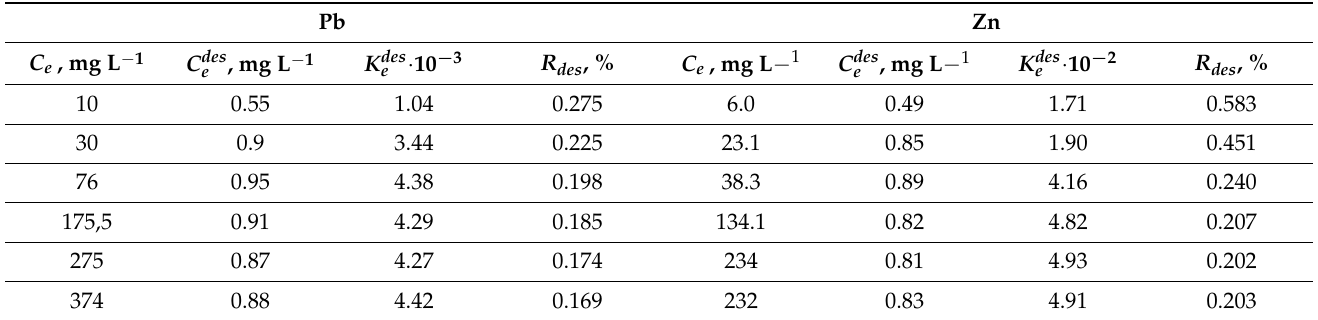
Table 7. Calculated parameters of the desorption process for both